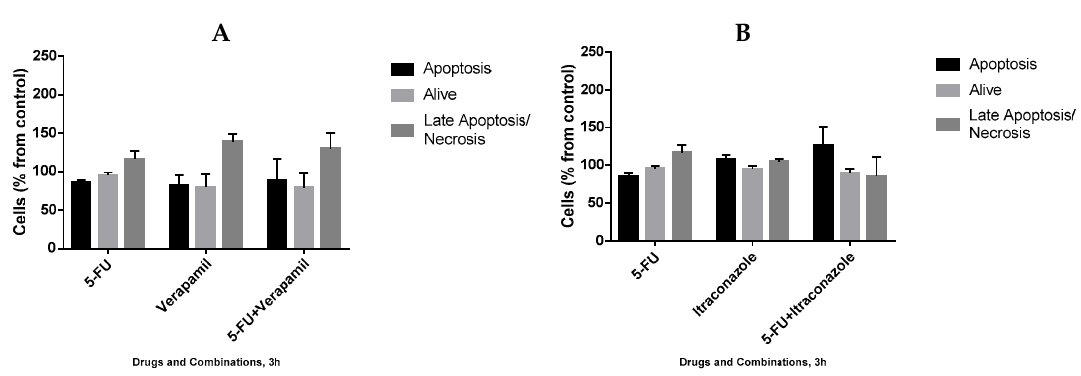
Figure 12. Effect of 5-FU, verapamil ( A ), itraconazole ( B ), and respective combinations of the last two drugs with 5-FU on the death of MCF-7 cells, for 3 h. Each drug and drug combination were added in fresh medium, in duplicates. Results are presented as mean ± SEM of two independent experiments.